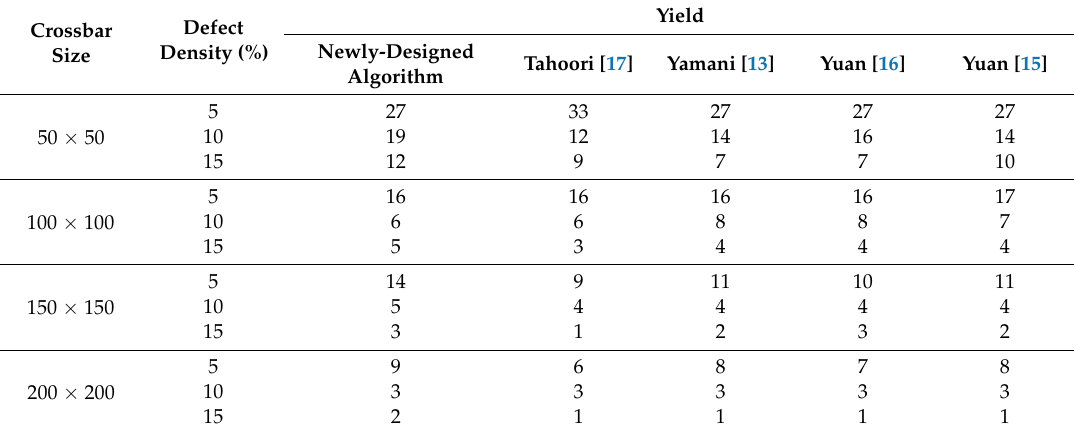
Table 2. Yield comparison of different defect-unaware fault-tolerant algorithms. Defect Crossbar Density (%) Size